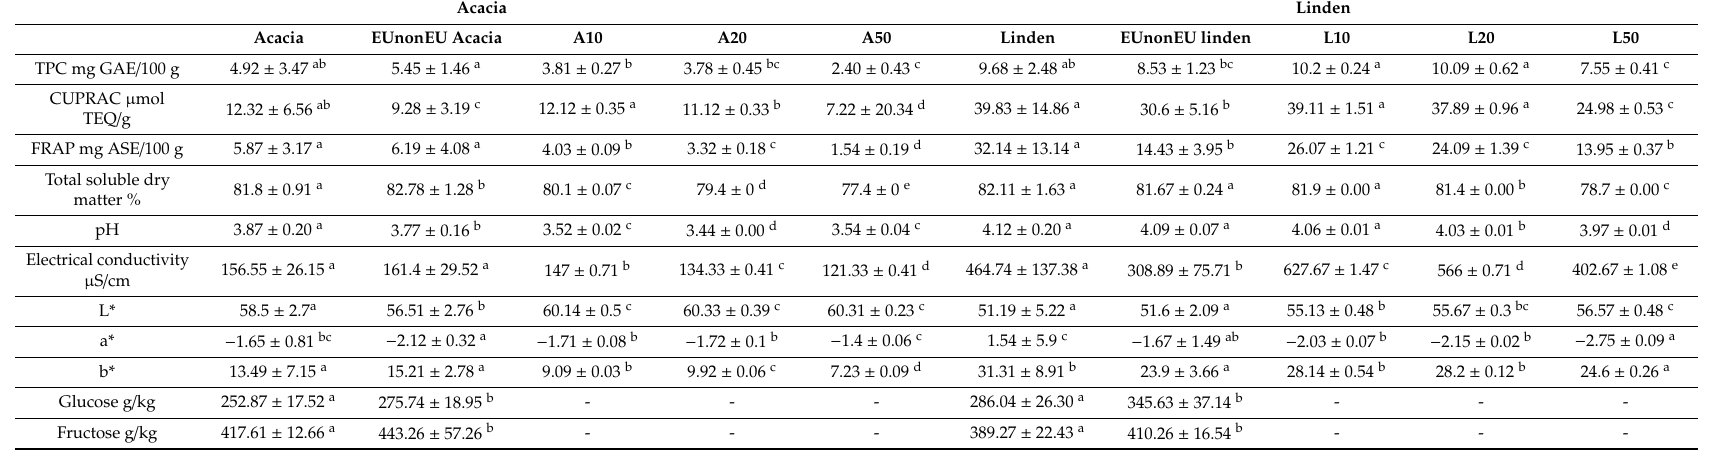
Table 3. Physicochemical, antioxidant and colour properties of acacia and linden honey types.